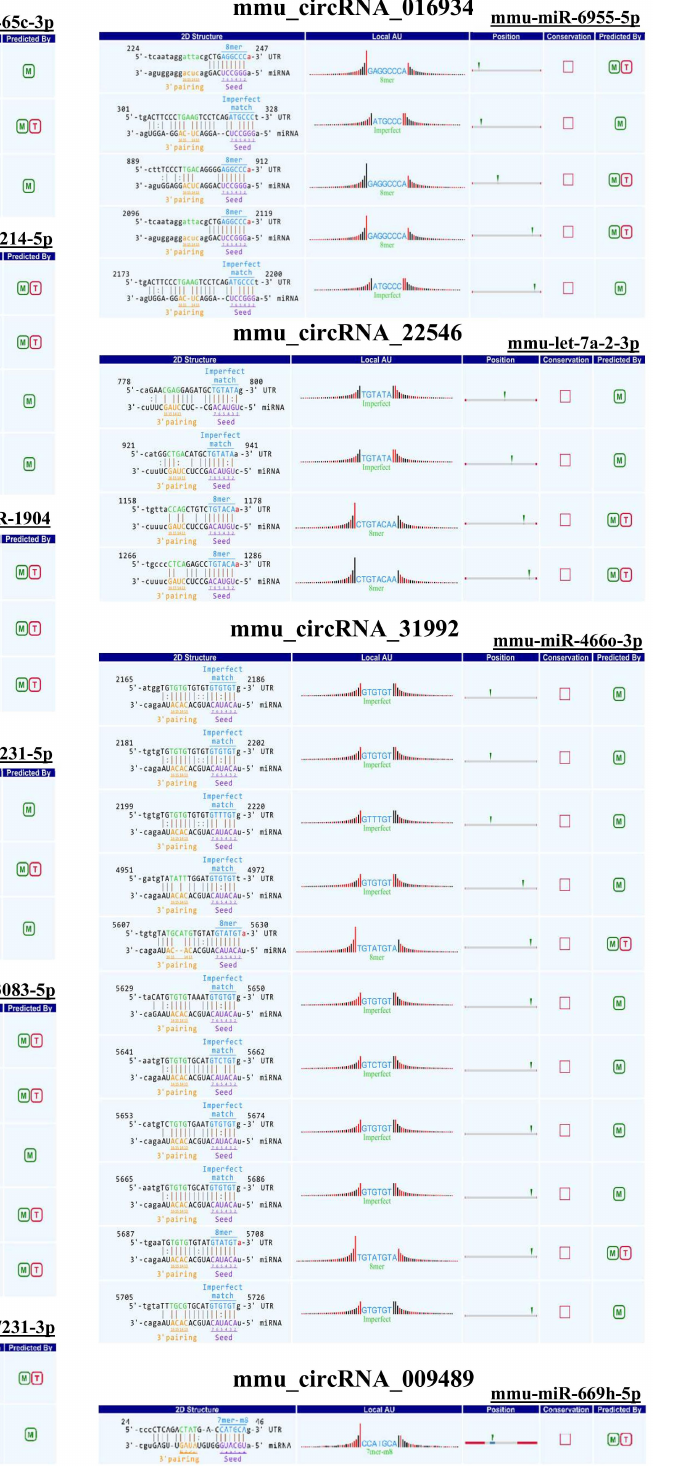
Frontiers in Molecular Neuroscience |